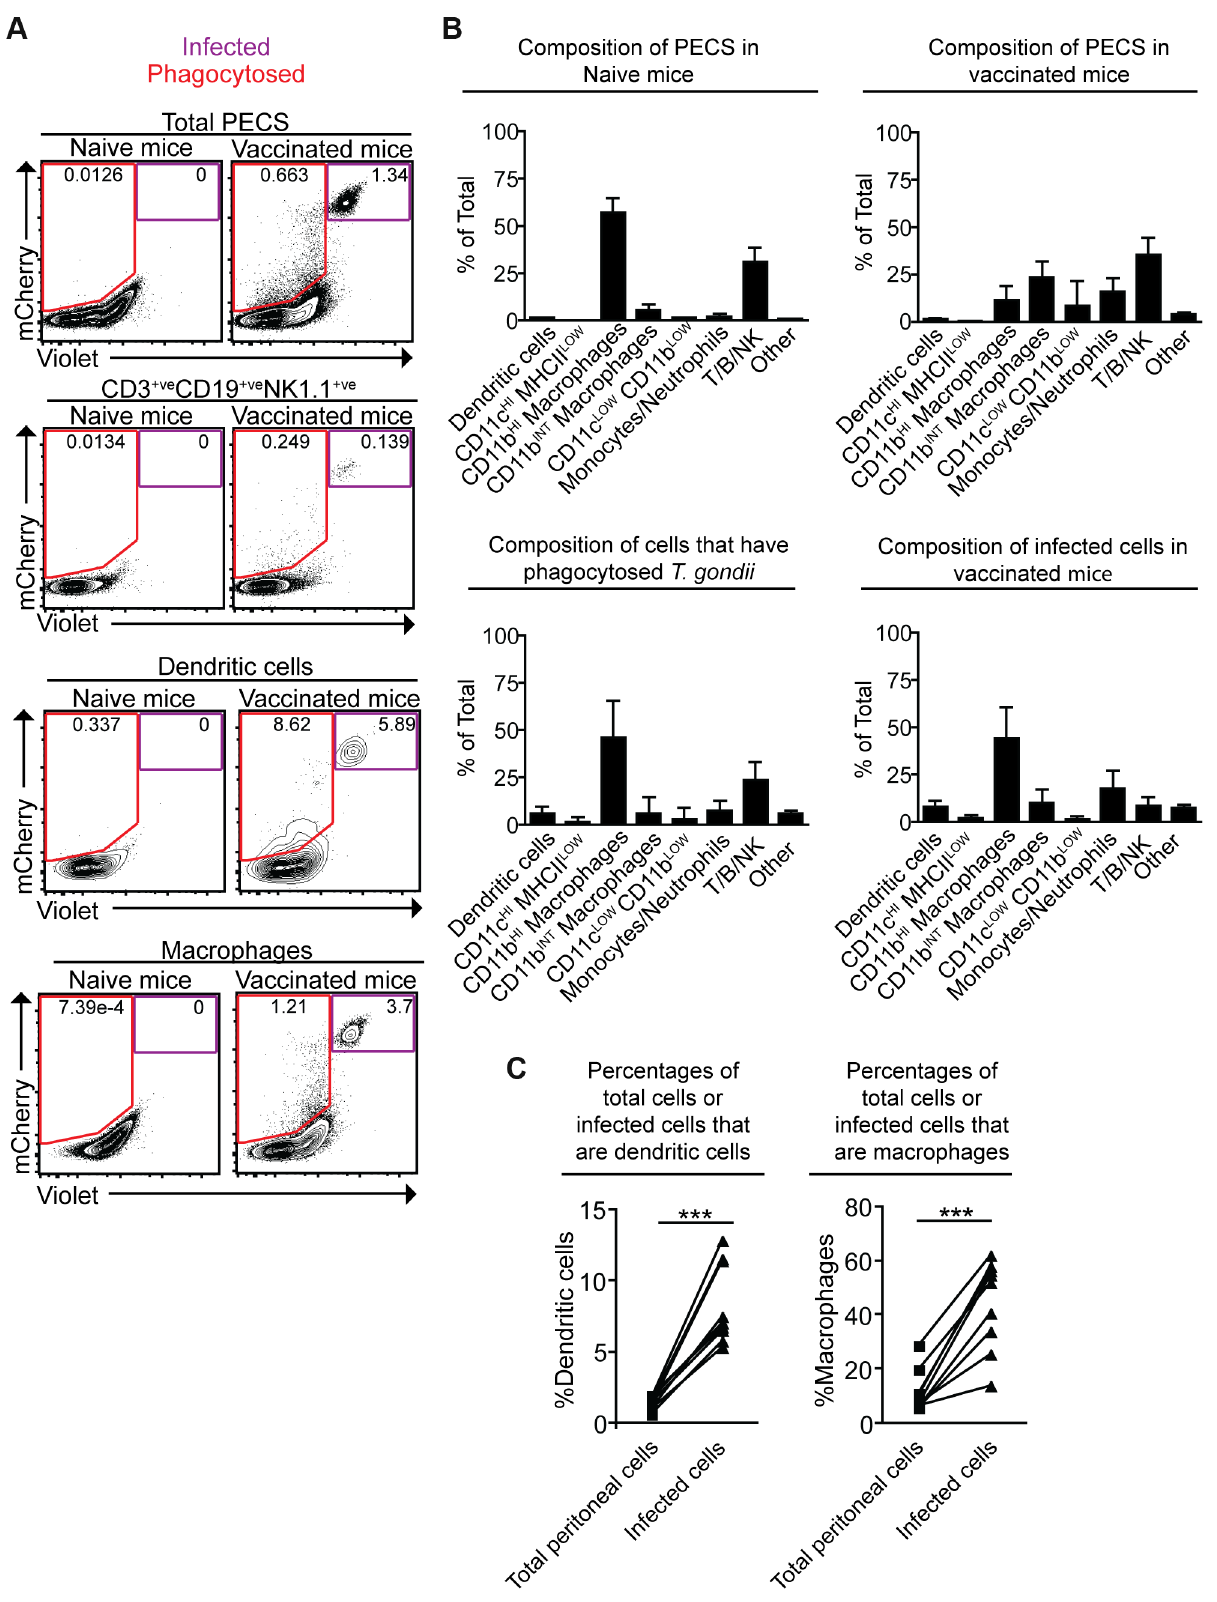
Figure 3. Composition of total cell populations, mCherry + ve Violet 2 ve cell populations, and mCherry + ve Violet + ve populations from the PECS of naı¨ve and vaccinated mice. Mice were vaccinated with 10 6 Violet-labeled, mCherry-expressing cpsII parasites intraperitoneally and sacrificed 18 hours post-vaccination. Cell type composition of total peritoneal cell populations in naı ¨ ve and vaccinated mice, and the cell type